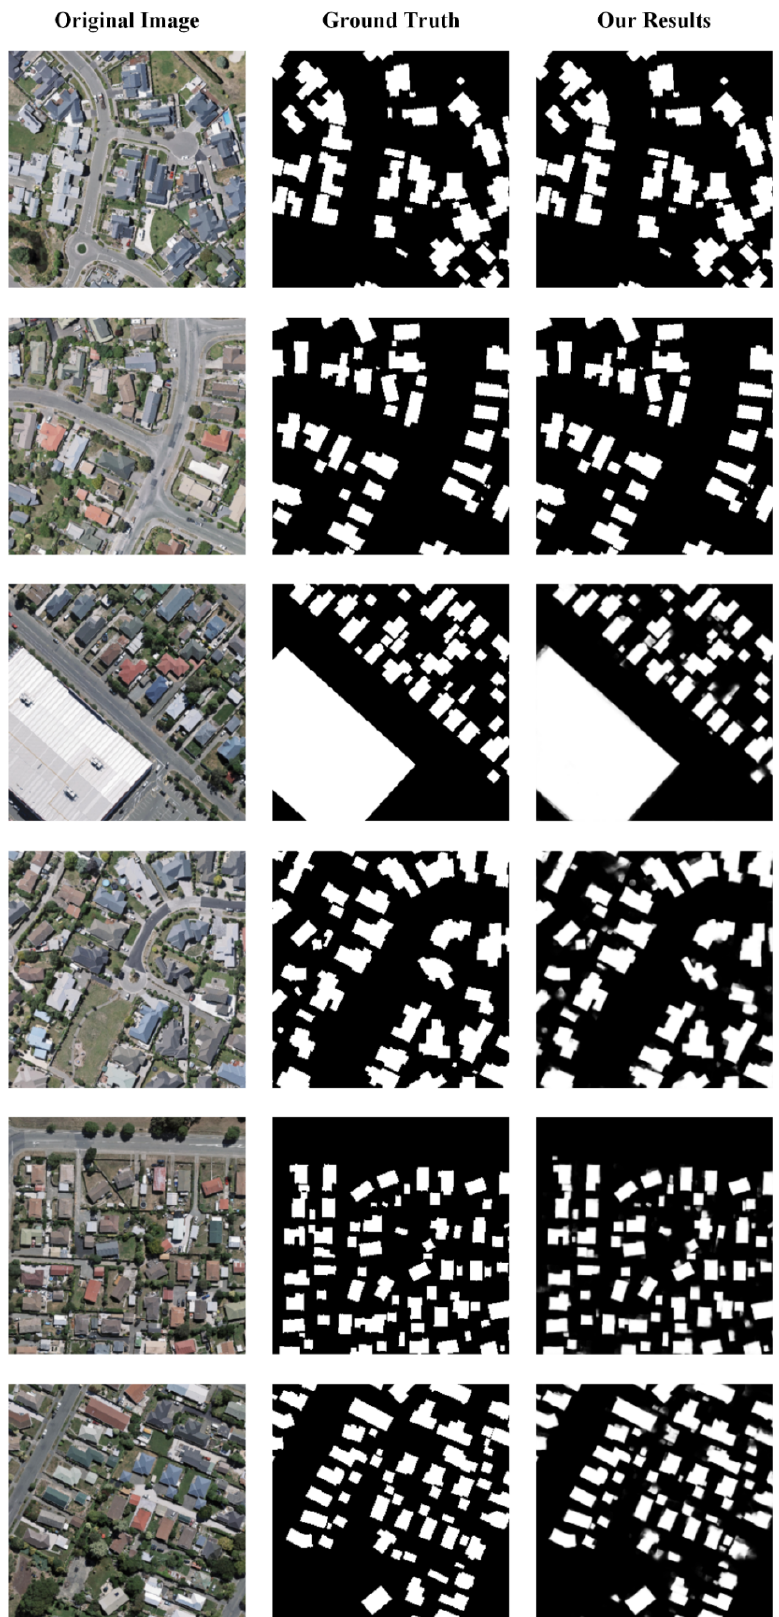
Figure 6. Building extraction results of our methods. The first, second and third columns are the original images, ground truths and our extraction results, respectively.